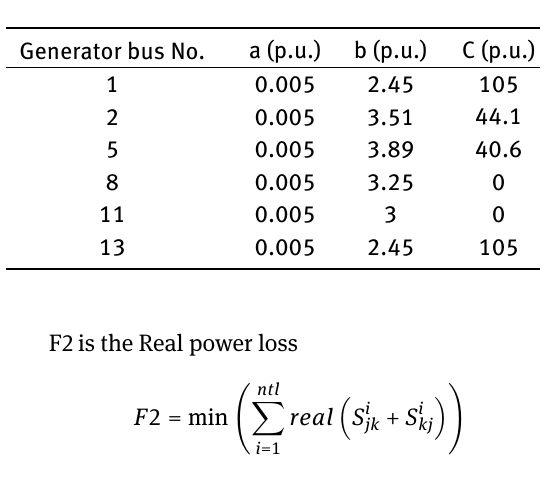
Table 1: Values of a, b, c for fuel cost